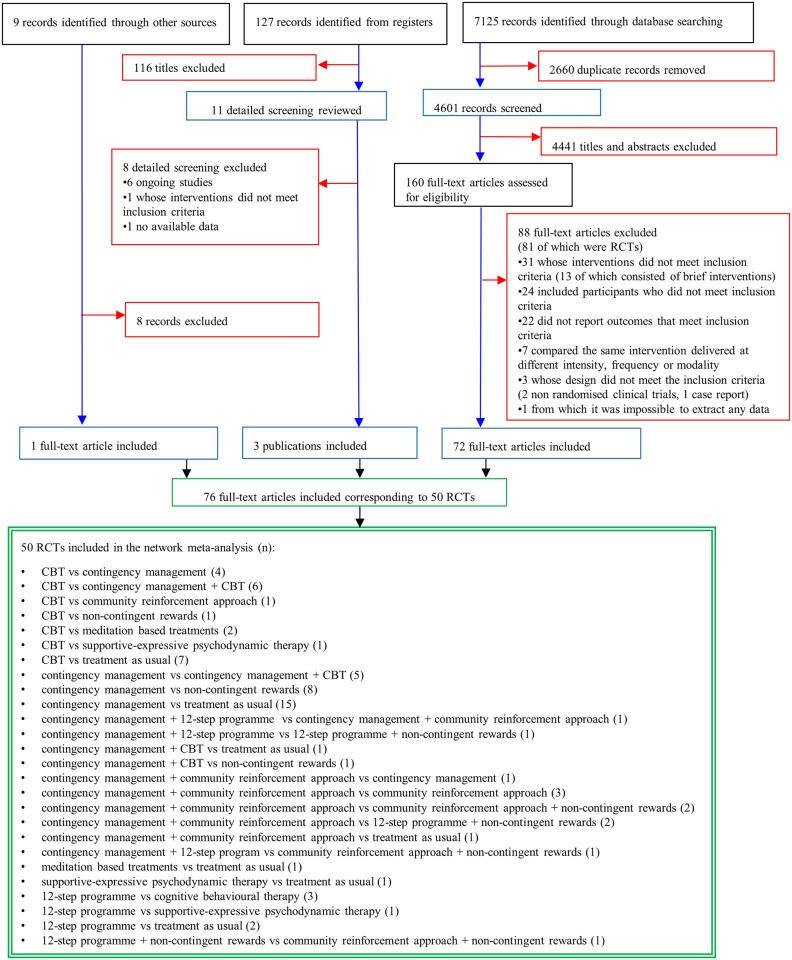
Study selection.The flowchart shows the records identified through database searching (black boxes), the records screened (blue boxes), the records excluded (red boxes), and the studies included (green boxes). CBT, cognitive behavioural therapy; RCT, randomised controlled trial.